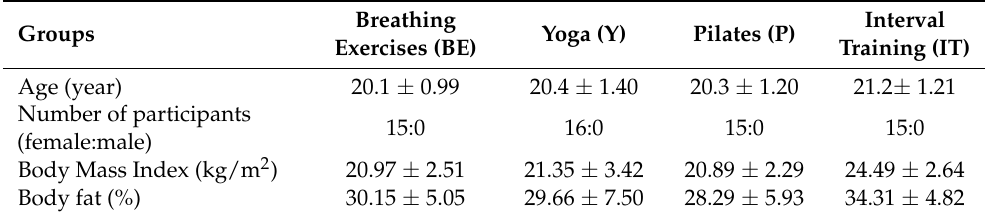
Table 1. Anthropometric data of university students who participated in four different training programmes (mean ±